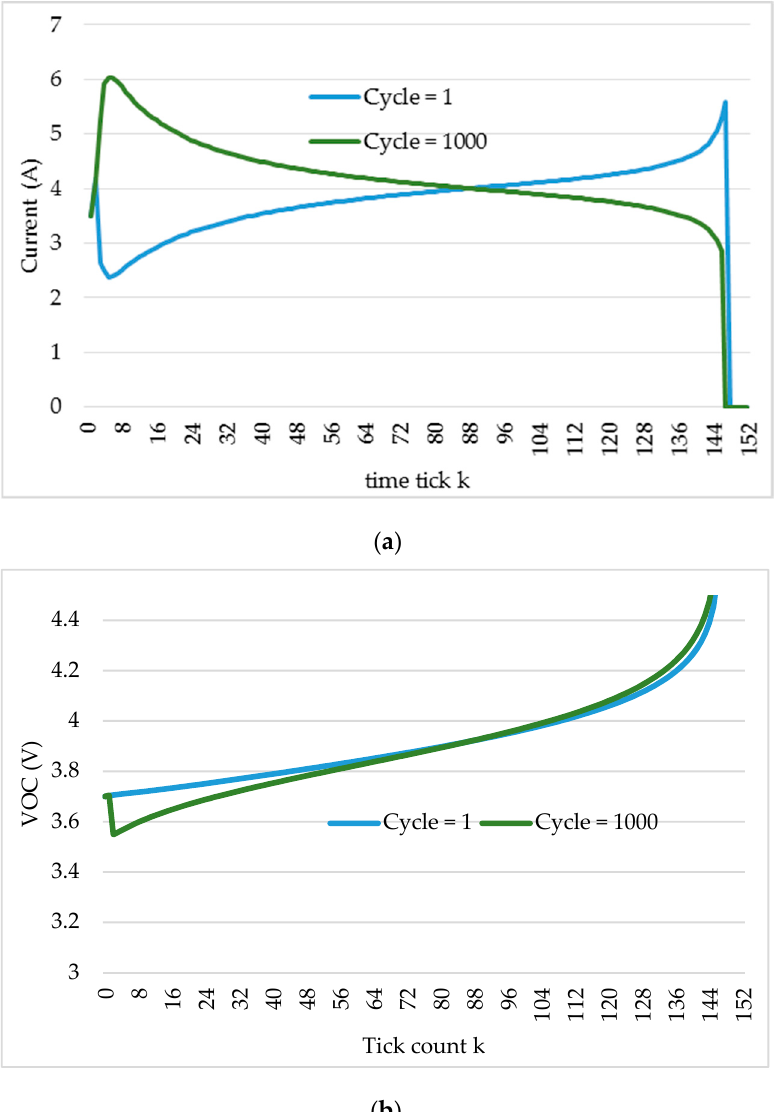
Figure 10. Simulation of parallel charging; ( a ) the current responses and ( b ) the voltage responses on different branches.